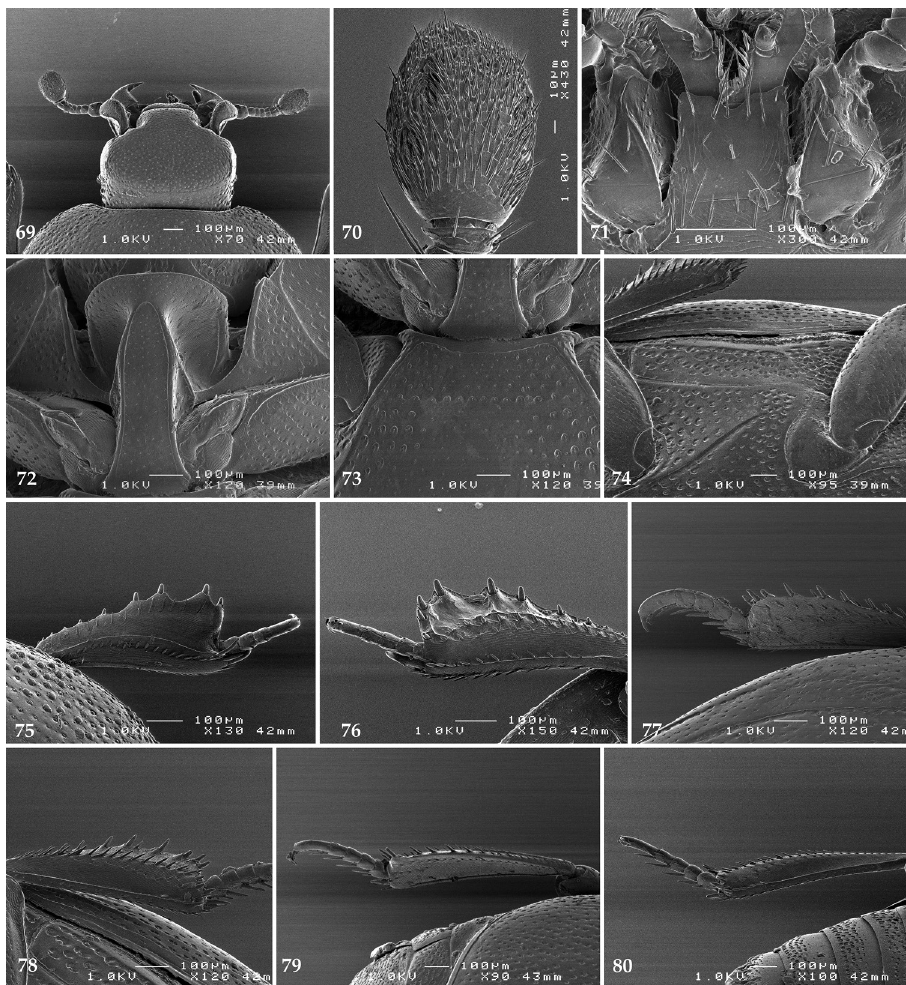
view showing sensory structures of the antenna 71 mentum, ventral view 72 prosternum 73 mesoventrite 74 lateral disc of metaventrite + metepisternum 75 protibia, dorsal view 76 ditto, ventral view 77 mesoti- bia, dorsal view 78 ditto, ventral view 79 metatibia, dorsal view 80 ditto, ventral